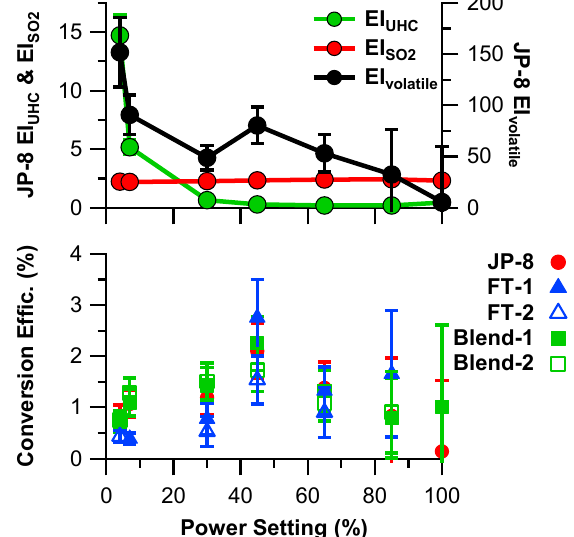
Fig. 13. Emissions indices for gas-phase hydrocarbons (gkg − 1 ), sulfate (gkg − 1 ), and volatile aerosol mass (mgkg − 1 ) for JP-8 (top) and conversion efficiency measured for all the fuels (bottom). Ef- ficiencies for the FT fuels at high power are not included because there was no significant volatile aerosol formation. Uncertainties for the gas-phase EIs are small (12%) and often not apparent in the fig- ure. At high engine power, conversion efficiency uncertainties are high due to the reduced volatile aerosol formation. Data are solely from the #3